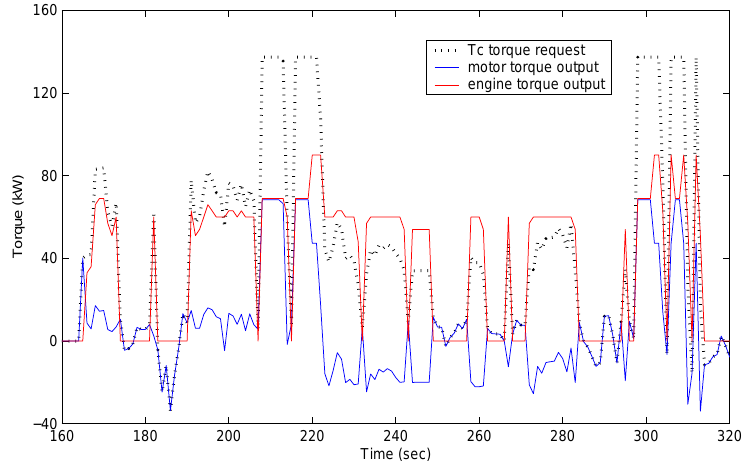
Figure 6. Torque split trajectory using SDP EMS under UDDS.